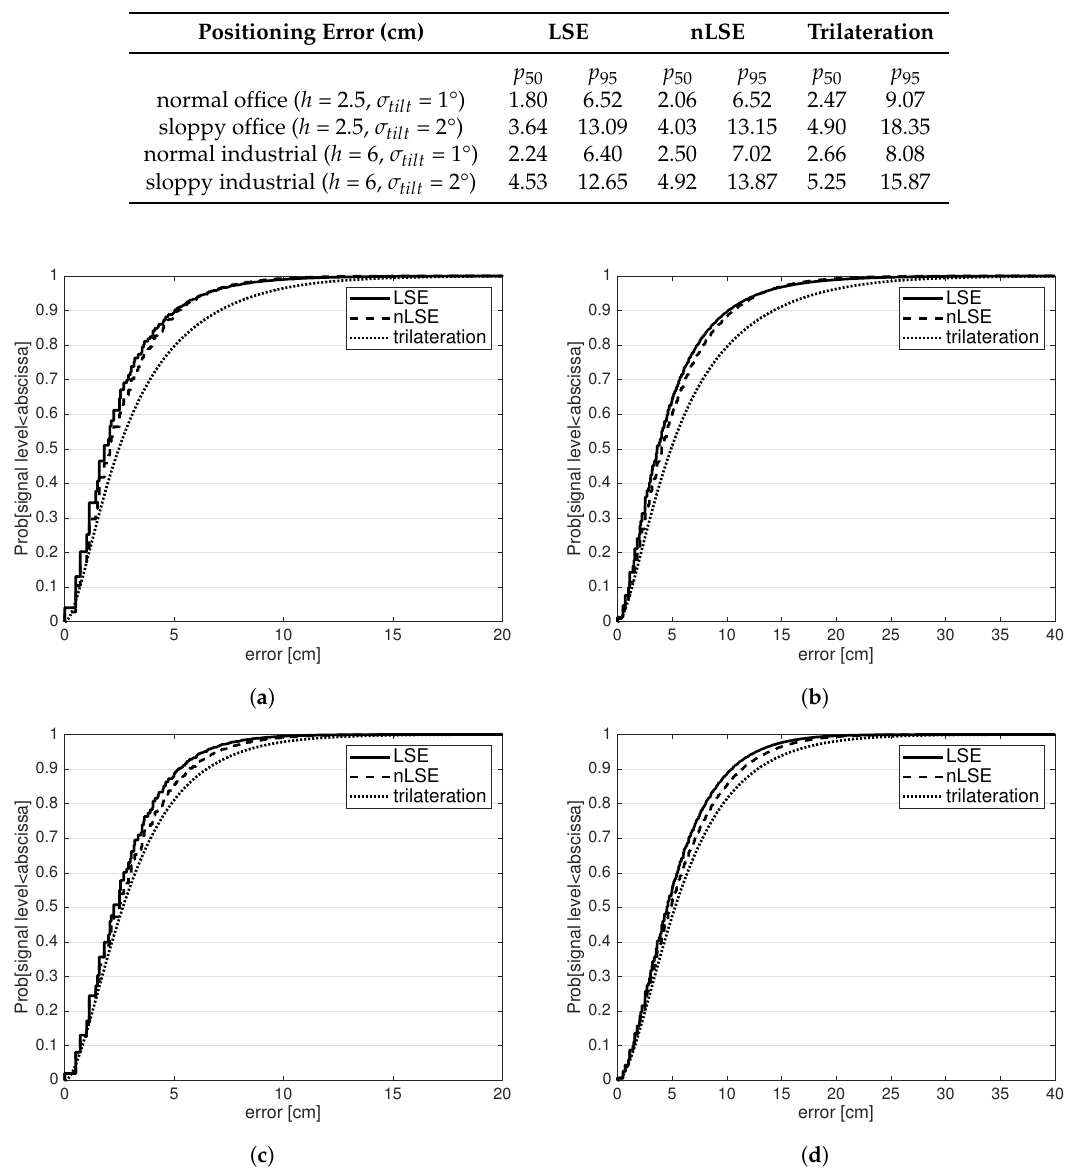
Figure 4. Cdf of the positioning errors at the evaluation locations (blue dots in Figure 3) for three positioning metrics. ( a ) Normal office placement (LED-PD height difference = 2.5 m, σ tilt = 1°); ( b ) Sloppy office placement (LED-PD height difference = 2.5 m, σ tilt = 2°); ( c ) Normal industrial placement (LED-PD height difference = 6 m, σ tilt = 1°); ( d ) Sloppy industrial placement (LED-PD height difference = 6 m, σ tilt =